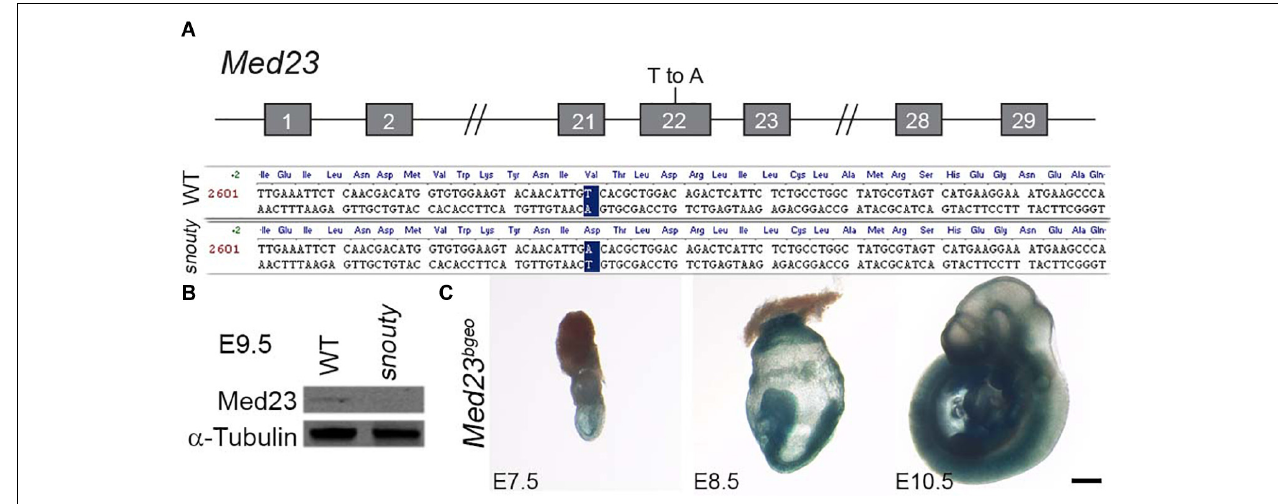
FIGURE 2 | s nouty mutant mice have a mutation in the Med23 gene. (A) The snouty mouse mutant phenotype was determined to be caused by a single base pair mutation in Exon 22 of the Med23 gene, which leads to a valine to aspartic acid amino acid change in the protein. Chromosome position of the mutation is noted based on mm10 mouse assembly. (B) Western blot against Med23 shows a drastic reduction of Med23 protein levels in snouty mutant embryos. (C) Ubiquitous expression of LacZ throughout E7.5 to E10.5 embryos is indicative of the Med23 expression. Scale bar is 250 um.